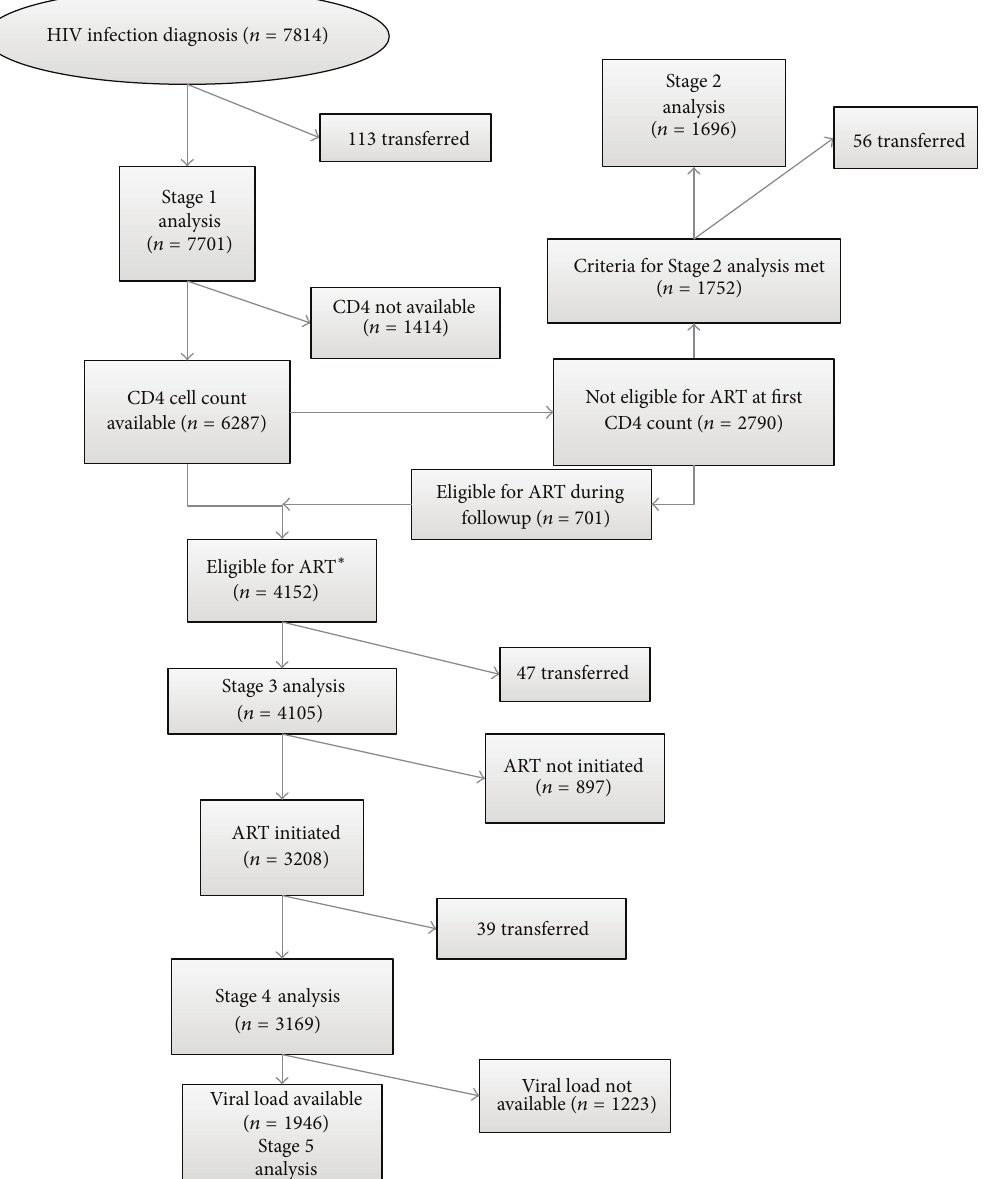
Figure 1: Flowchart of patients included in each stage of HIV care. ART, antiretroviral therapy; ∗ 46 patients having a first CD4 cell count < 250 cells/ 𝜇 L were excluded because the CD4 count determination was performed after November 4th